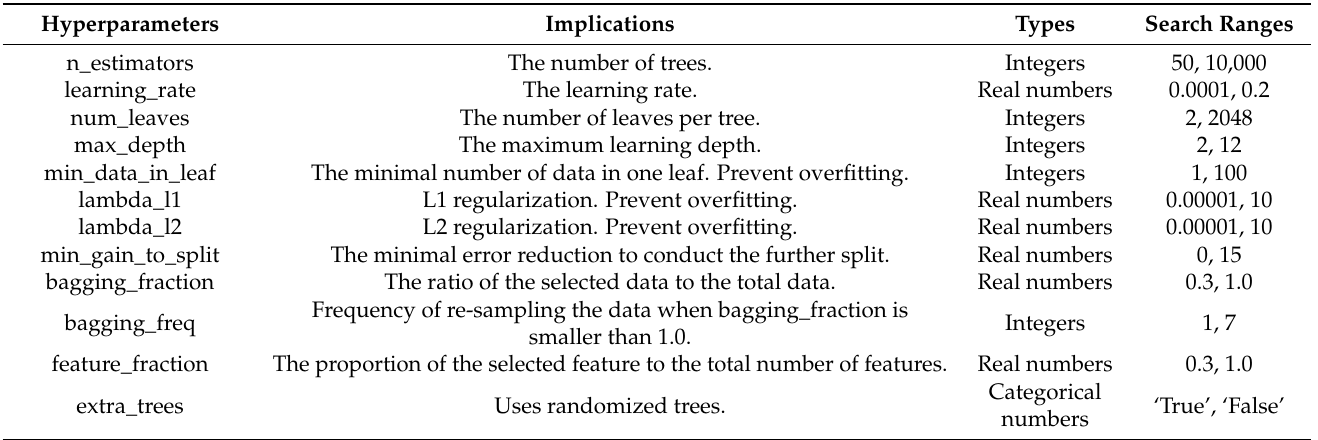
Table 8. Hyperparameters of the LightGBM model tuned in this study